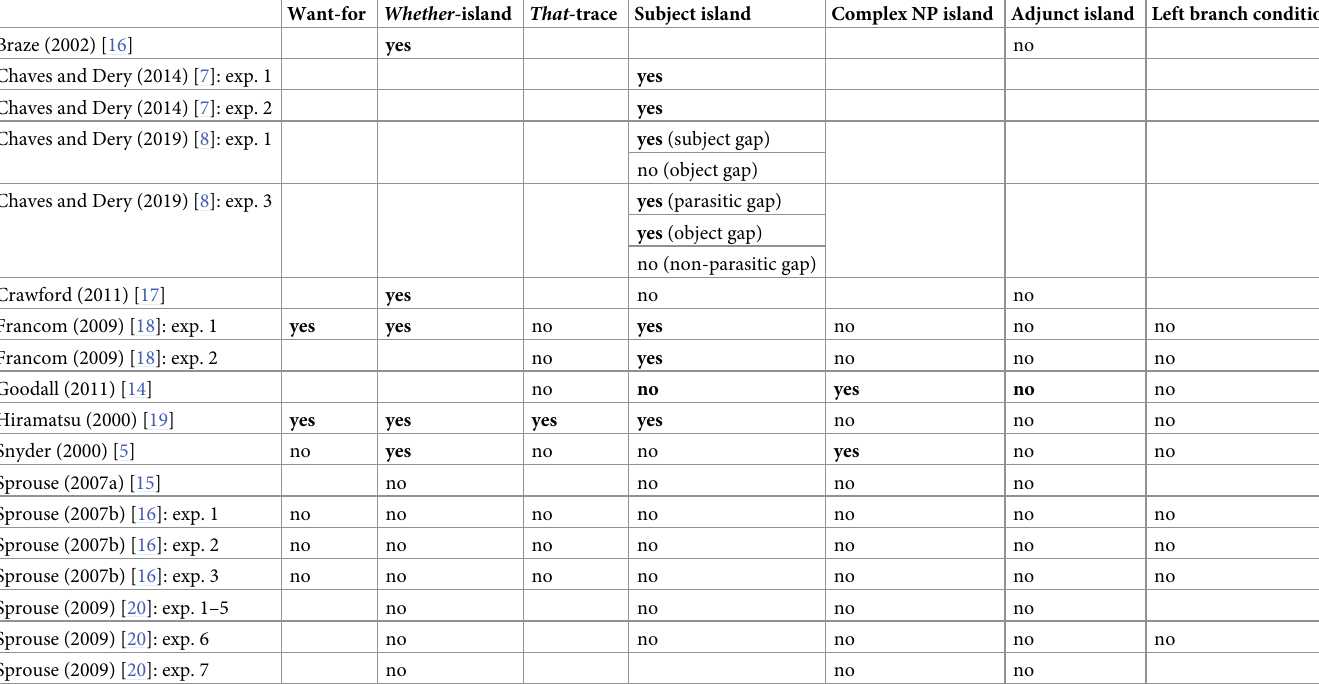
Table 1. Summary of satiation effects by previous study and